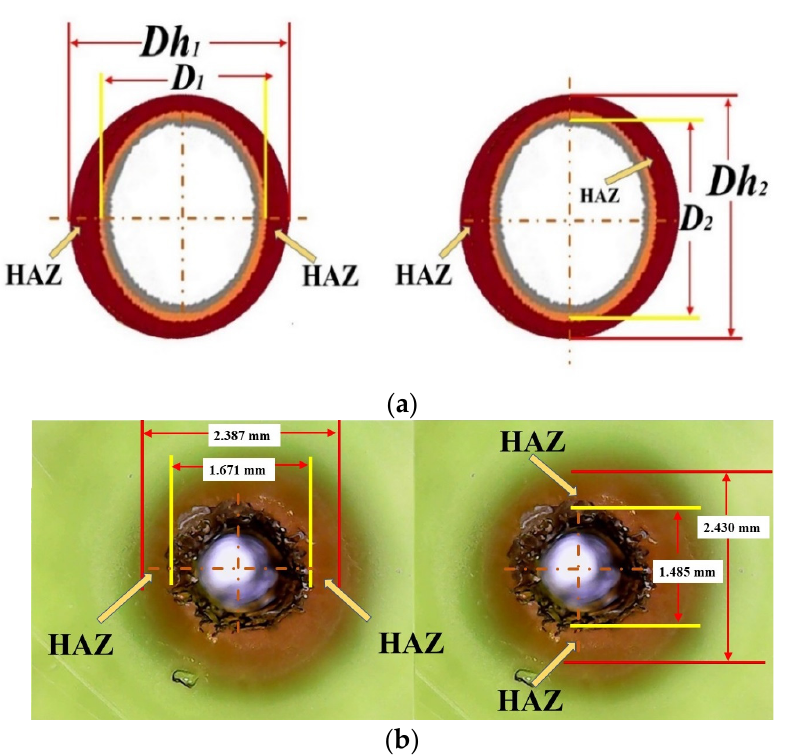
Figure 5. ( a ) Schematic of HAZ measurement. ( b ) Actual photo of HAZ measurement.